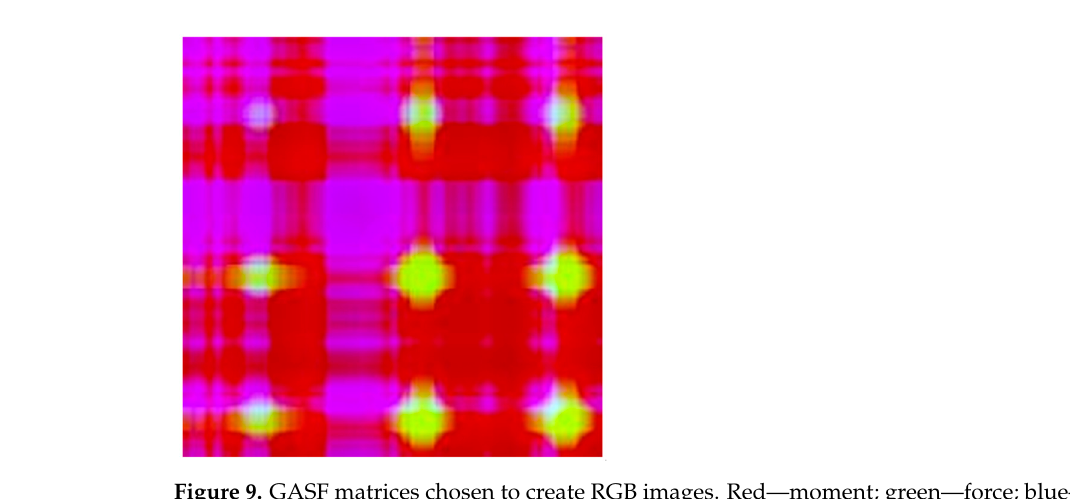
level meter. level